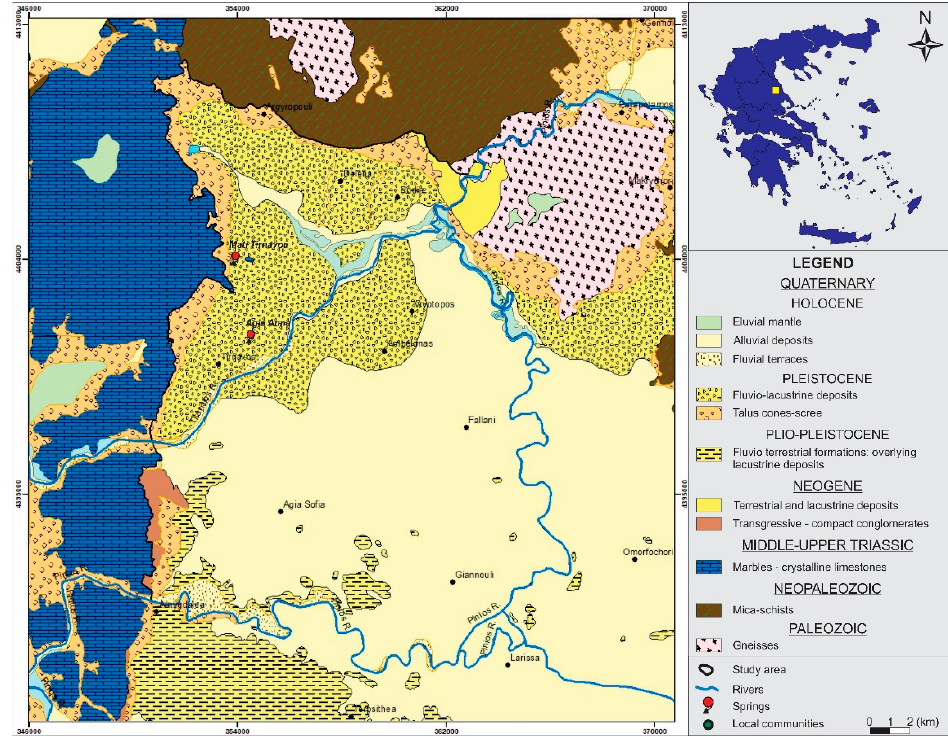
Figure 2. Geological map of the case study area, based on [30,31].